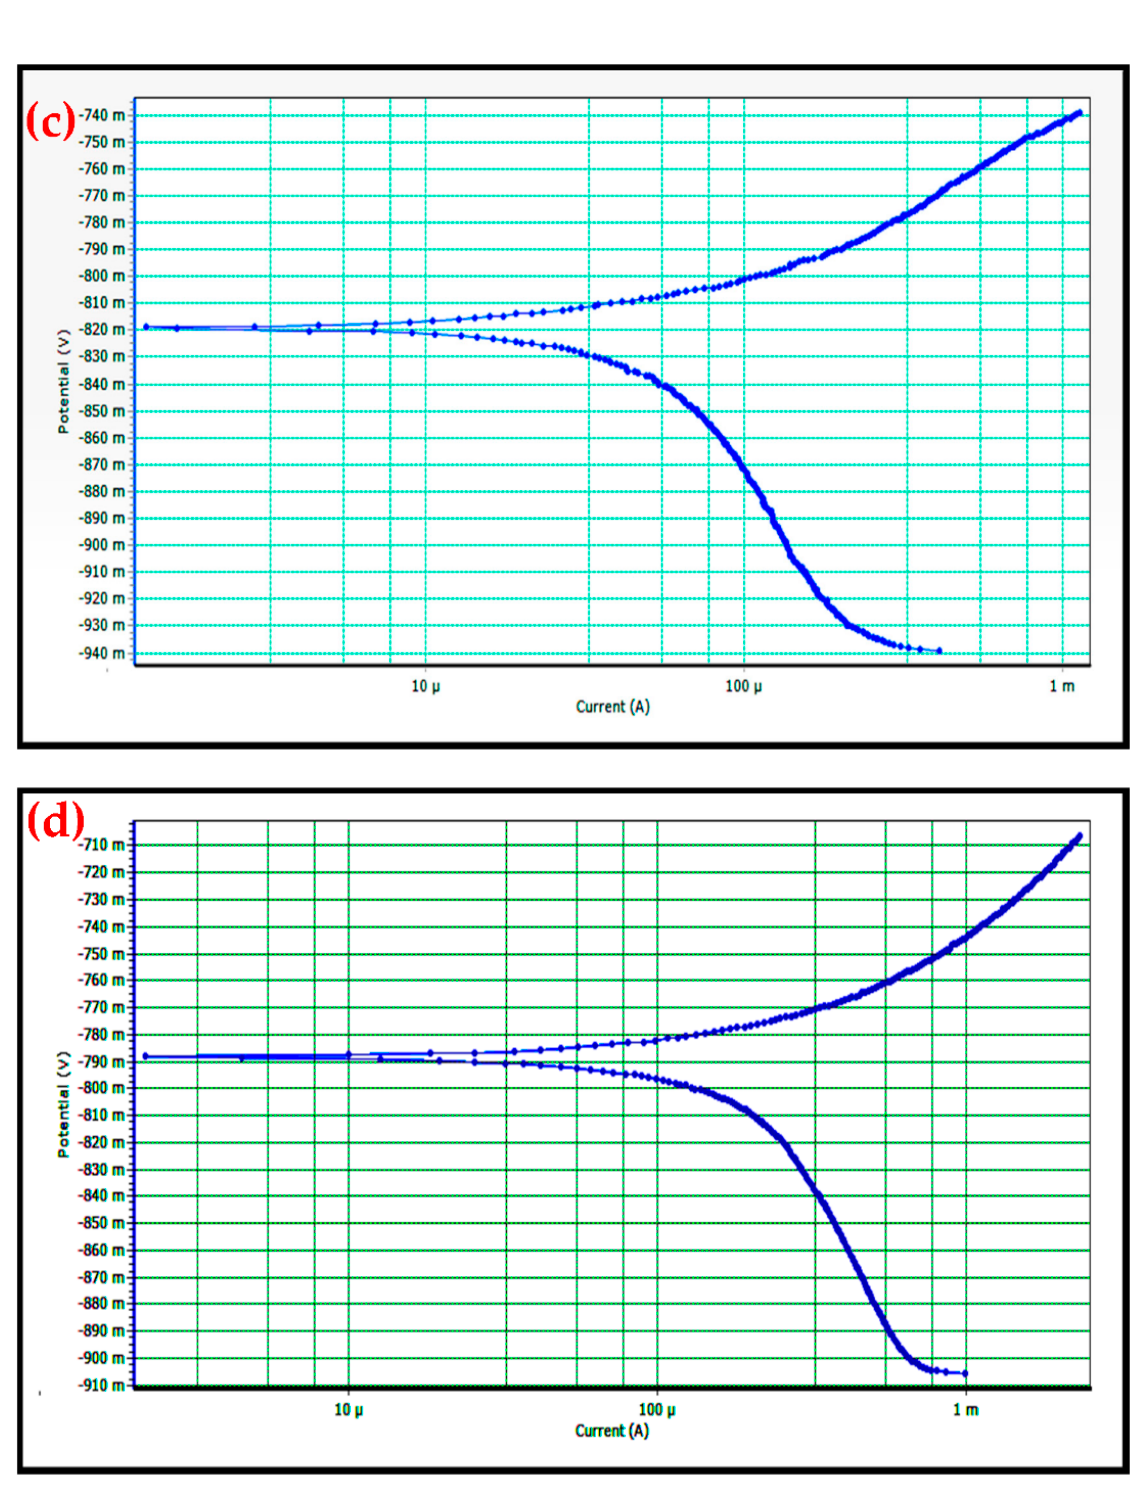
Figure 11. ( a – d ) Polarization curves for ( a ) AA8079, ( b ) AA8079-5 wt.%B 4 C, ( c ) AA8079-10 wt.%B 4 C, and ( d ) AA8079-15 Figure 11 . ( a – d ) Polarization curves for ( a ) AA8079, ( b ) AA8079-5wt.%B4C, ( c ) AA8079-10wt.%B4C, wt.%B 4 C composites in 3.5% NaCl and ( d ) AA8079-15wt.%B4C composites in 3.5% NaCl solution.